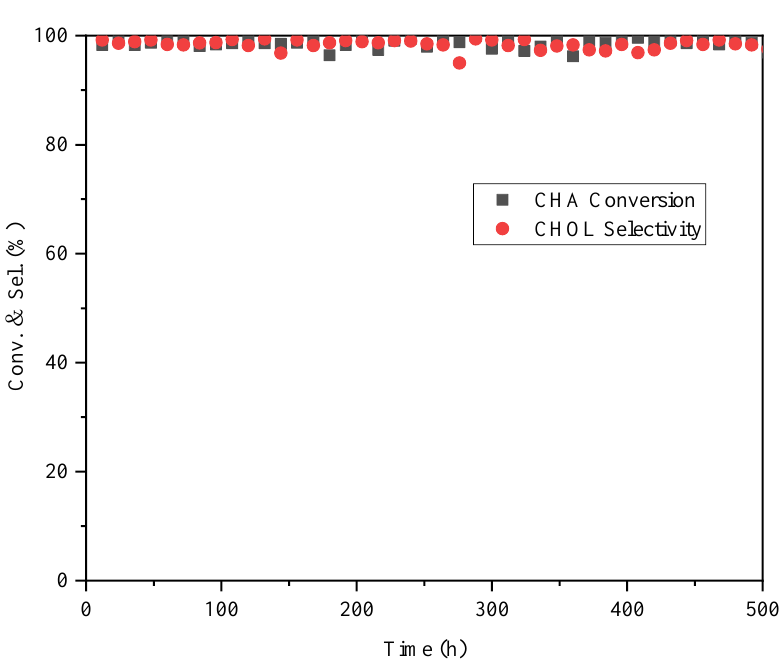
Figure 5. Long-term performance of CHA hydrogenation over CMA-L. Reaction conditions: 473 K, H 2 pressure: 2.5 MPa, H 2 /CHA molar ratio = 20:1, WHSV = 0.5 h −1 .